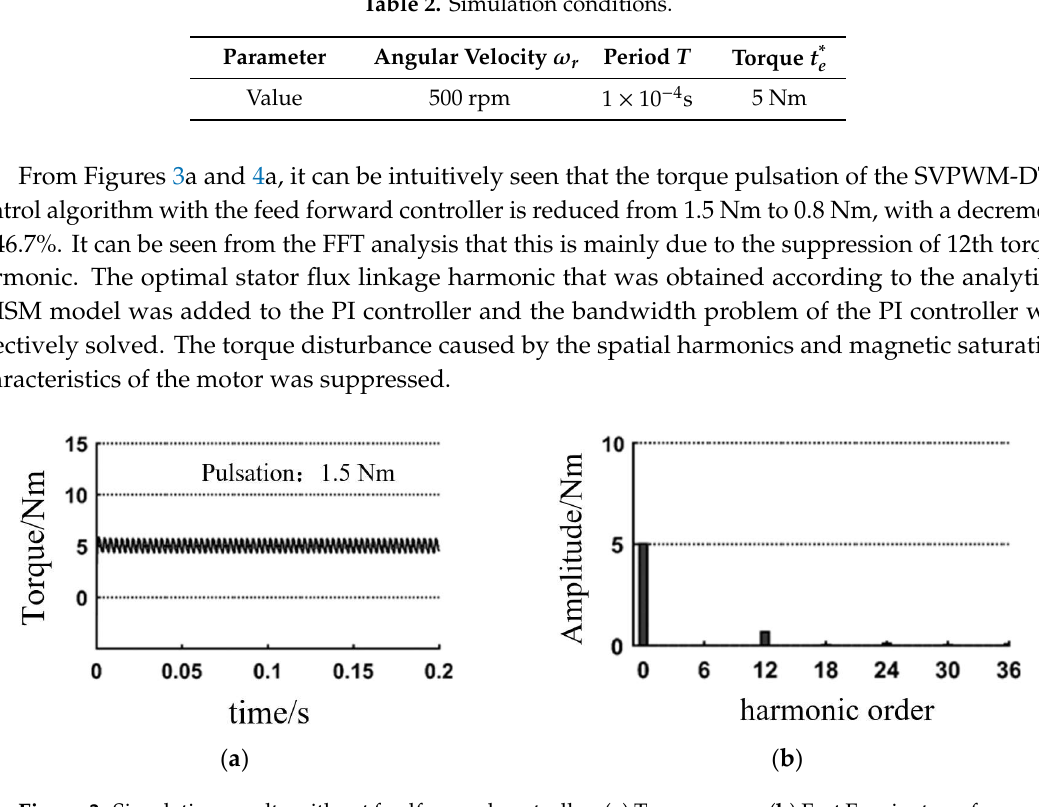
Figure 4. Simulation results with feedforward controller. ( a ) Torque wave; ( b ) FFT analysis of torque wave.